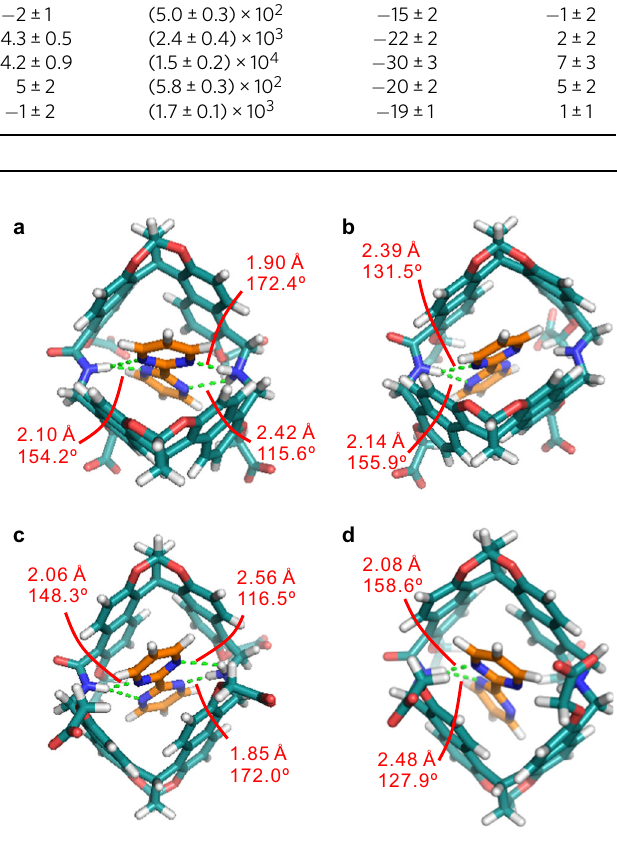
Fig. 5 Binding modes between 5 and G4. Energy-minimized structures of ( a ) G4 @ 5a ∙ H + , ( b ) G4 @ 5a , ( c ) G4 @ 5b ∙ H + and ( d ) G4 @ 5b calculated by DFT calculations (wB97XD/6 – 311 + G(d) and 6 – 311 G(d)) with the PCM solution model in water at 298 K. Color codes: carbon, celeste or orange; oxygen, red; nitrogen,